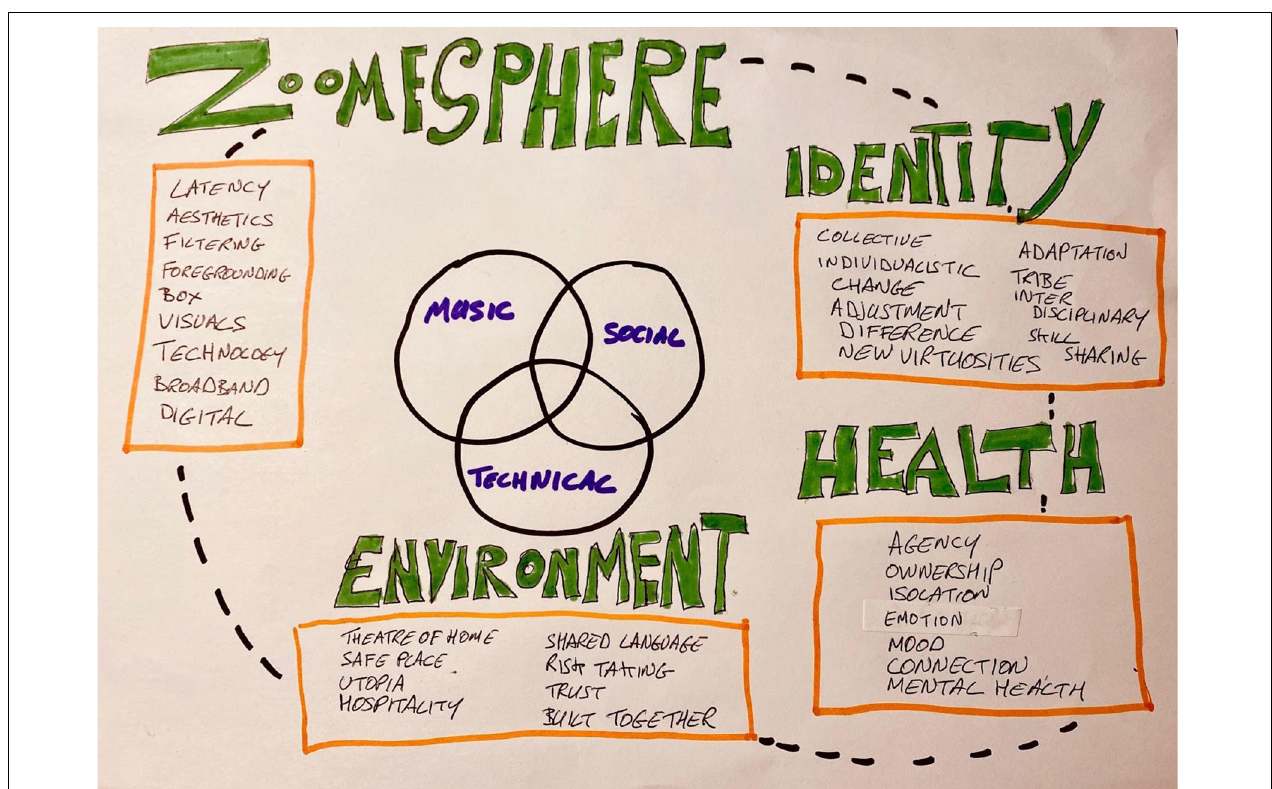
FIGURE 2 | Thematic